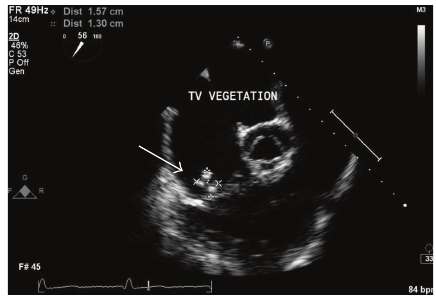
Figure 2: Tricuspid valve vegetation (arrow).